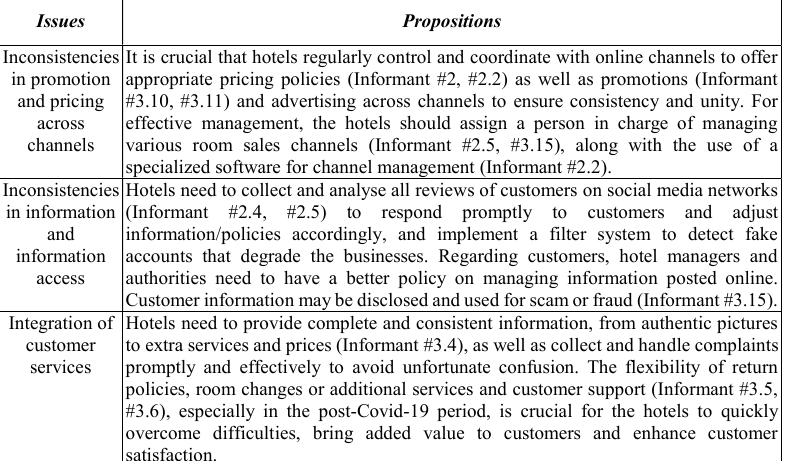
Table 2 . The propositions for improving channel integration